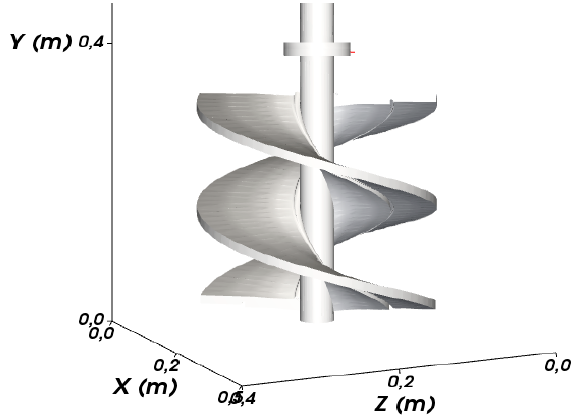
Figure 5. Vertimill 1:10 scale of the VTM-1500.